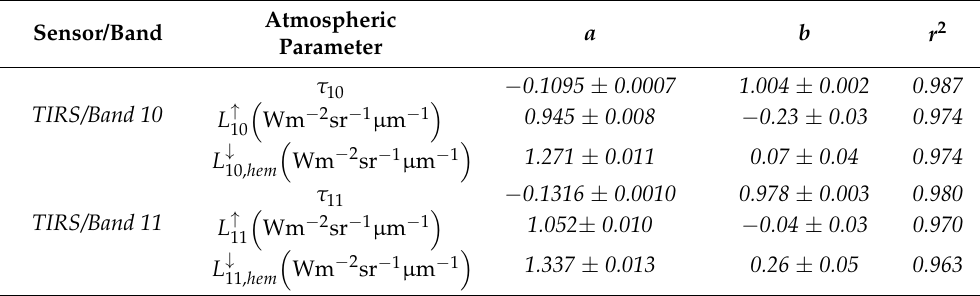
Figure 1. Plots of the atmospheric correction parameters, obtained from the CLAR database, versus water vapor content ( w ) for Landsat 8/TIRS bands 10 (top) and 11 (bottom). Dashed lines represent the linear adjustment. Table 1. Coefficients of the linear regressions between the atmospheric correction parameters and the water vapor content: slope (a), interception (b), and regression coefficient (r 2